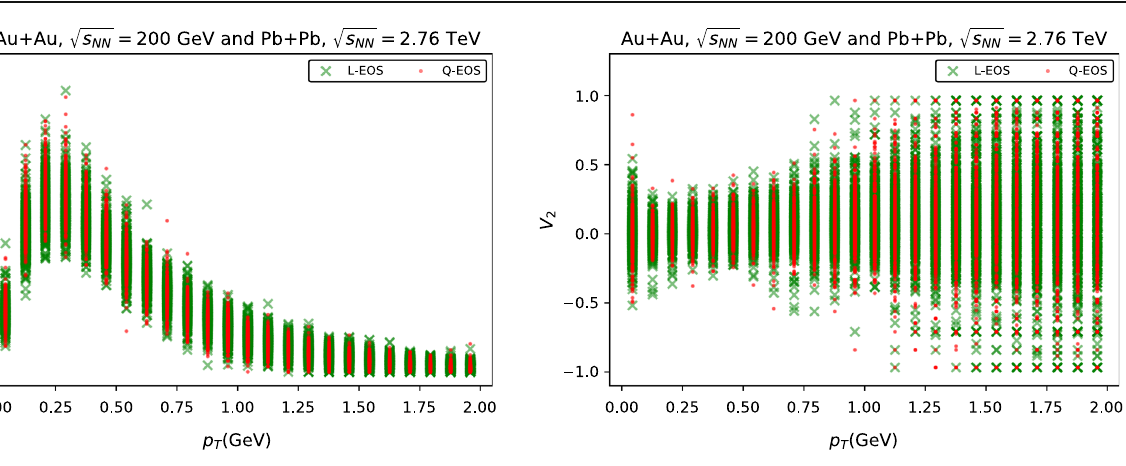
Fig. 6 Event-by-event normalized p T spectra d N / N d y d p T (left panel) and elliptic flow v 2 as a function of p T (right panel) of the training datasets in Tables 1 and 2 with two EoSs. Vertical discrepancy is event-by-event fluctuations. The green cross and the red point sym-